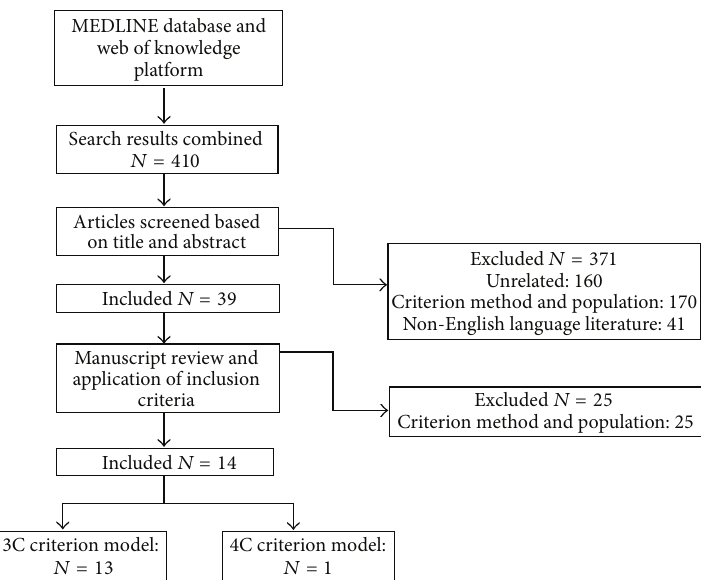
Figure 1: Flow diagram of study selection